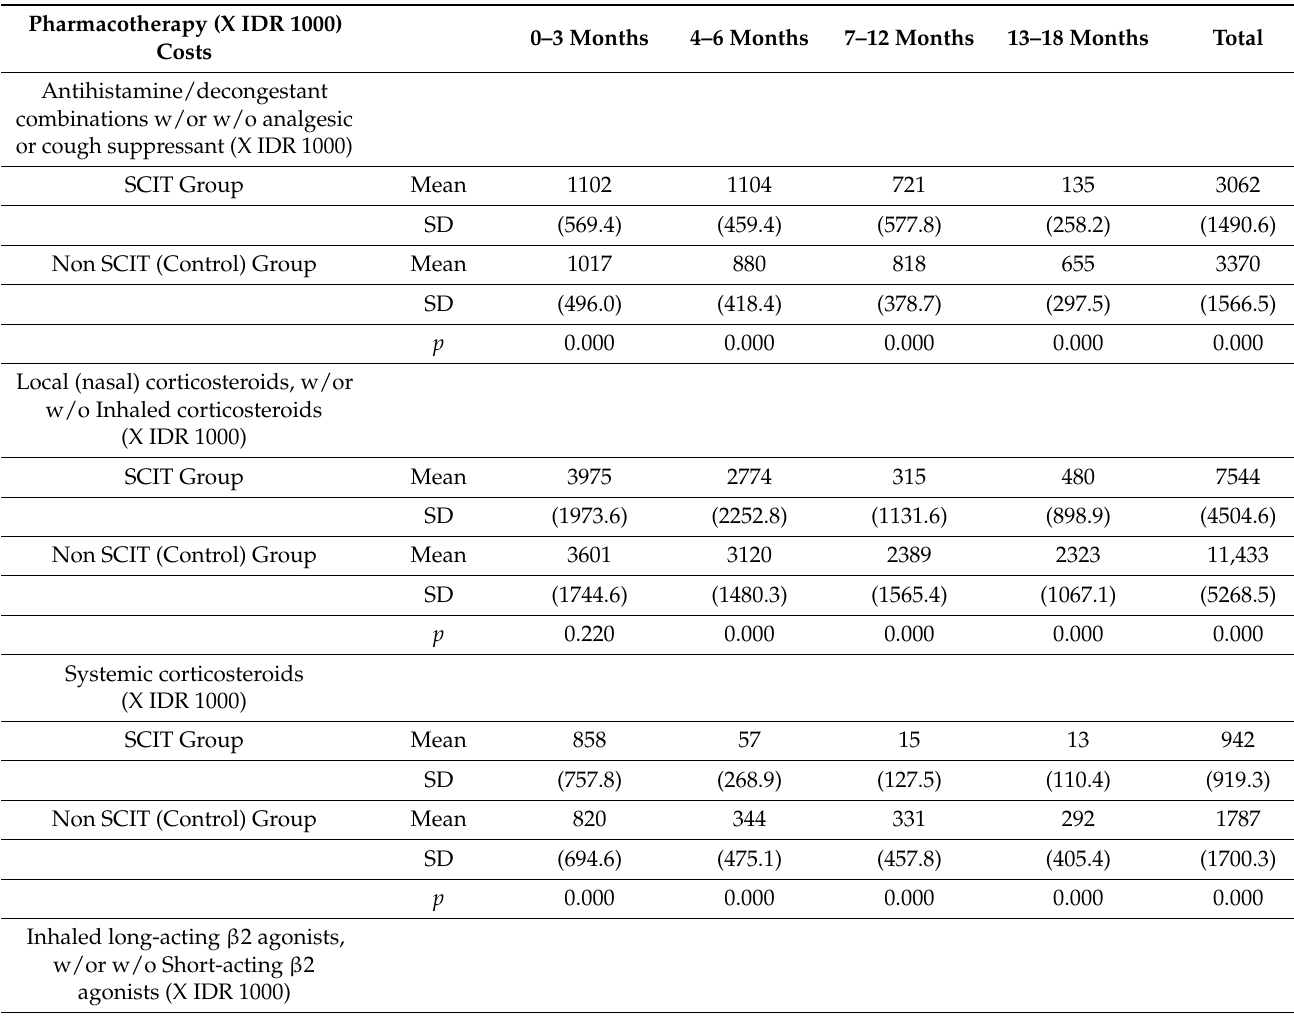
Table 5. Pharmacotherapy and physiotherapy